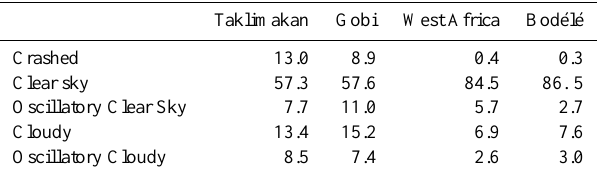
Taklimakan Gobi West Africa